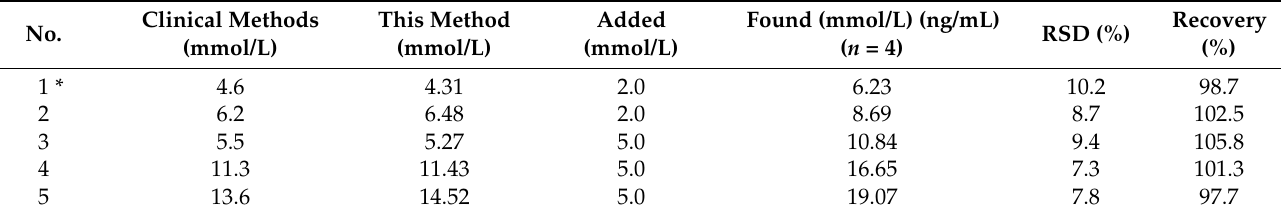
Table 1. Recovery of glucose in spiked serum